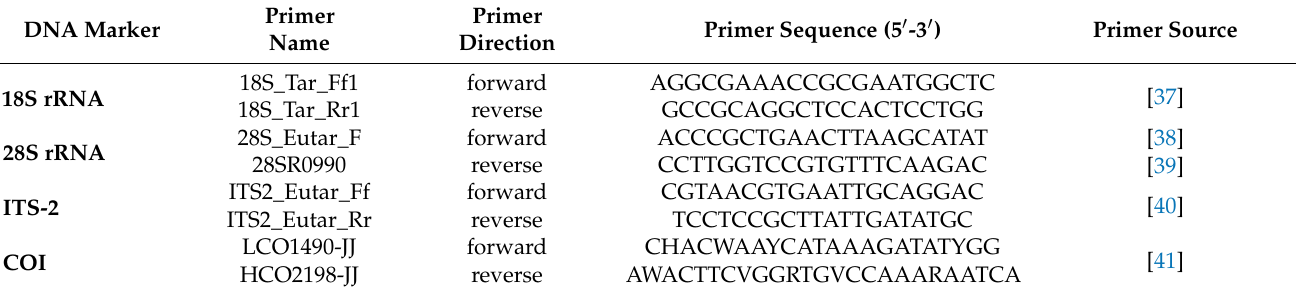
Table 1. Primers with their original references used for amplification of the four DNA fragments sequenced in the study. DNA